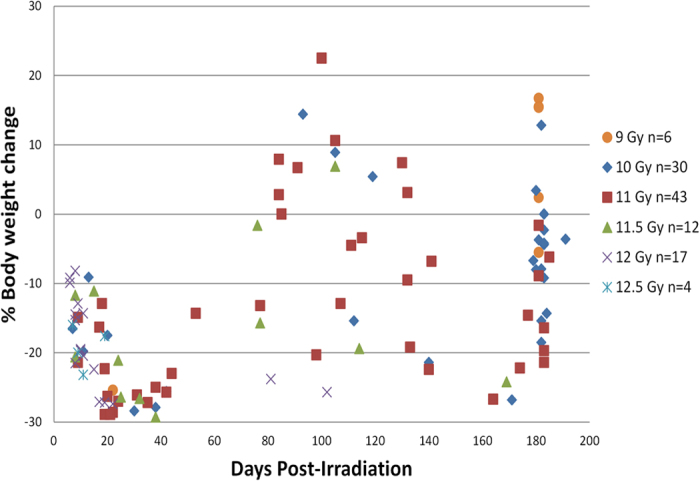
Body weight change at the time of euthanasia of NHP exposed to 9.0–12.5 Gy PBI/BM5.The % BW change of each individual NHP exposed to PBI/BM5 is plotted against the time when the NHP was euthanized. NHP exposed to different radiation doses are marked by different colors and shapes. Each dot represents one NHP.